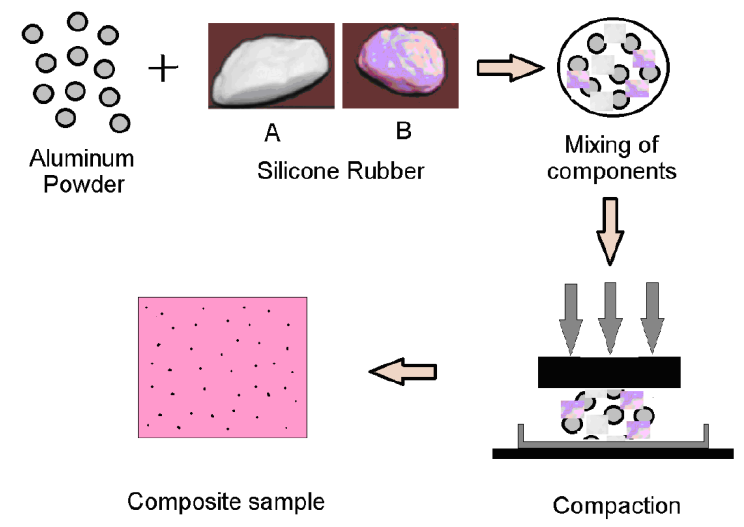
Figure 1. The stages of preparation process of the composite samples of silicone rubber with Al particles.